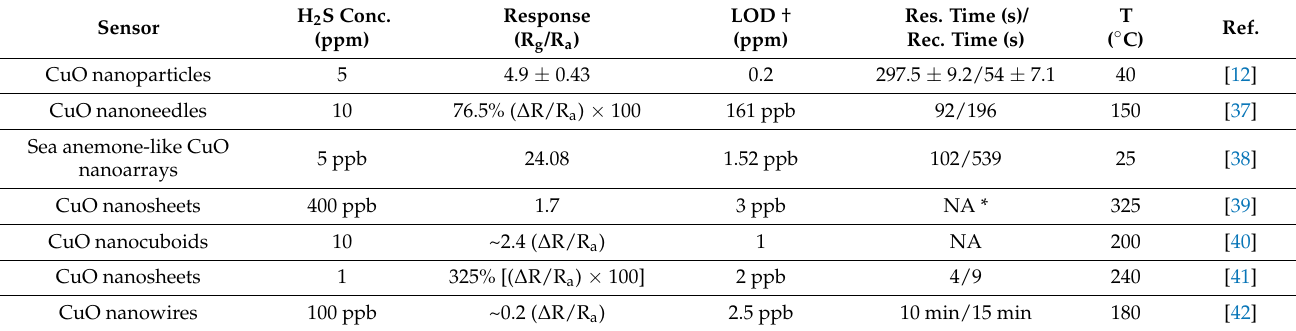
Figure 3. Energy band diagrams of CuO nanocuboid in ( a ) air and ( b ) H 2 S surroundings. Reprinted from [40] with permission from ACS. Table 2. H 2 S gas-sensing properties of pristine Cu x O-based gas